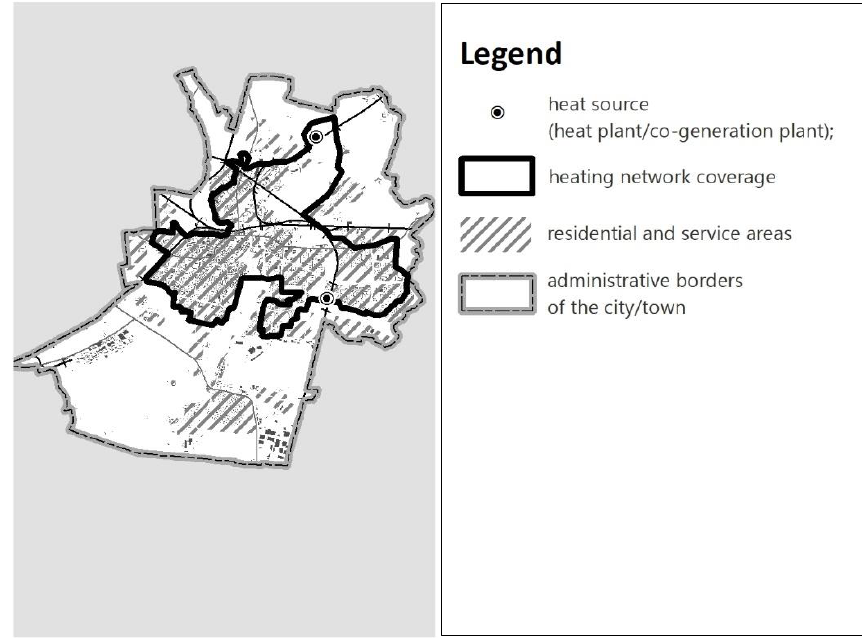
Figure 3. Areas intended for housing and service development, and the range of the district heat- ing network in Legnica. * HSAs—housing and service areas. network in Legnica. * HSAs—housing and service